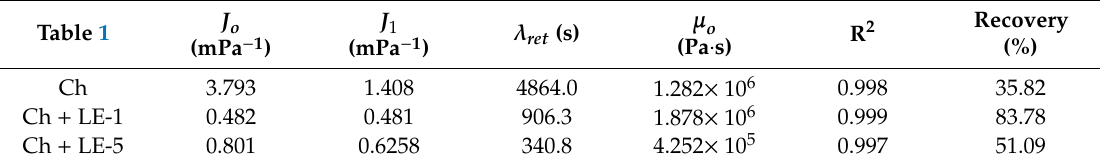
Table 5. Burger model parameters obtained for the films. Ch = Chitosan; Ch + LE-1 = Chitosan + 1% of licorice extract; Ch + LE-5 = Chitosan + 5% of licorice extract. Table